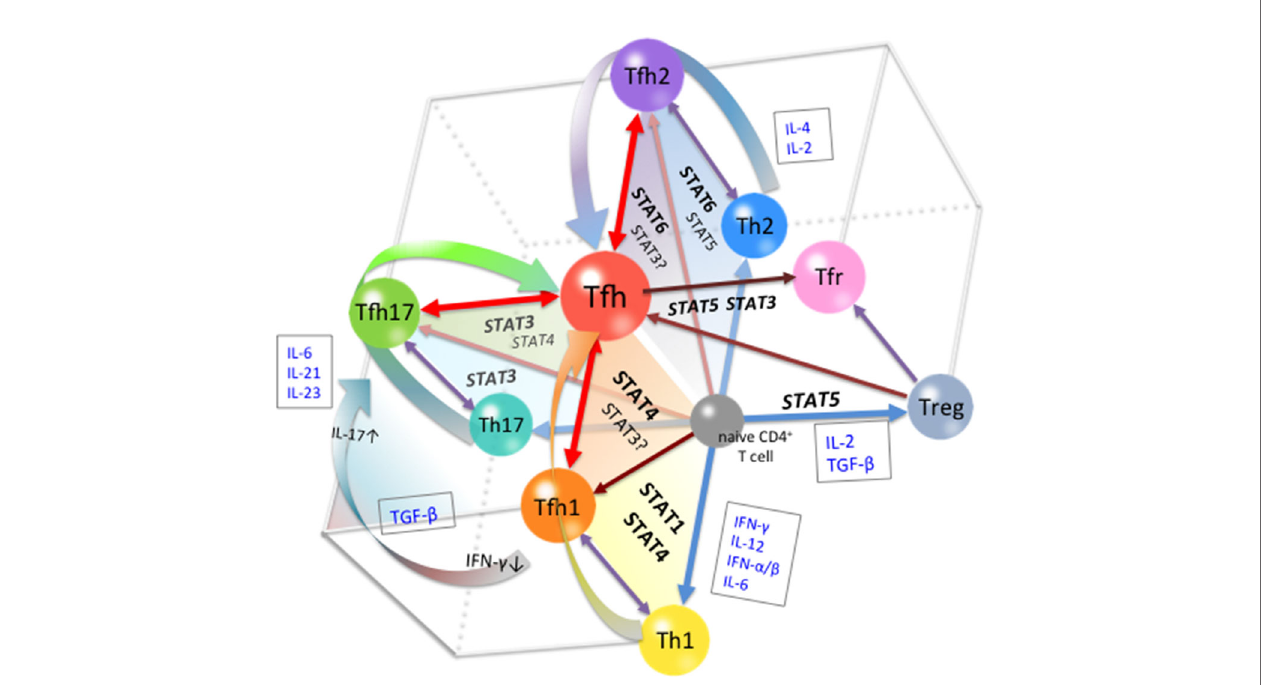
FIGURE 2 | Cytokine-STAT-mediated Multi-source Pathways of Tfh Differentiation. The pathway of differentiation is determined by the type of stimulus to which the pre-Tfh cells are exposed to during the initial stage of differentiation. STAT1/STAT4-activating cytokines, such as Type I IFN and IL-12, guide cells toward the Tfh1 differentiation pathway; STAT6/STAT5-activating cytokines, such as IL-4 and IL-2, guide cells toward the Tfh2 differentiation pathway; and STAT3-activating cytokines, such as IL-21, IL-6, and IL-23, guide cells toward the Tfh17 differentiation pathway. At subsequent stages, restriction among STATs limits the polarization of Tfh subsets, leading to the completion of Tfh cell